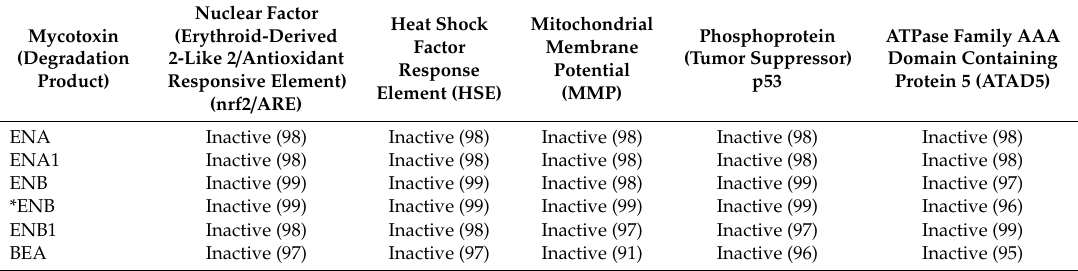
Table 5. Toxicological pathways: Stress response pathways predicted for detected